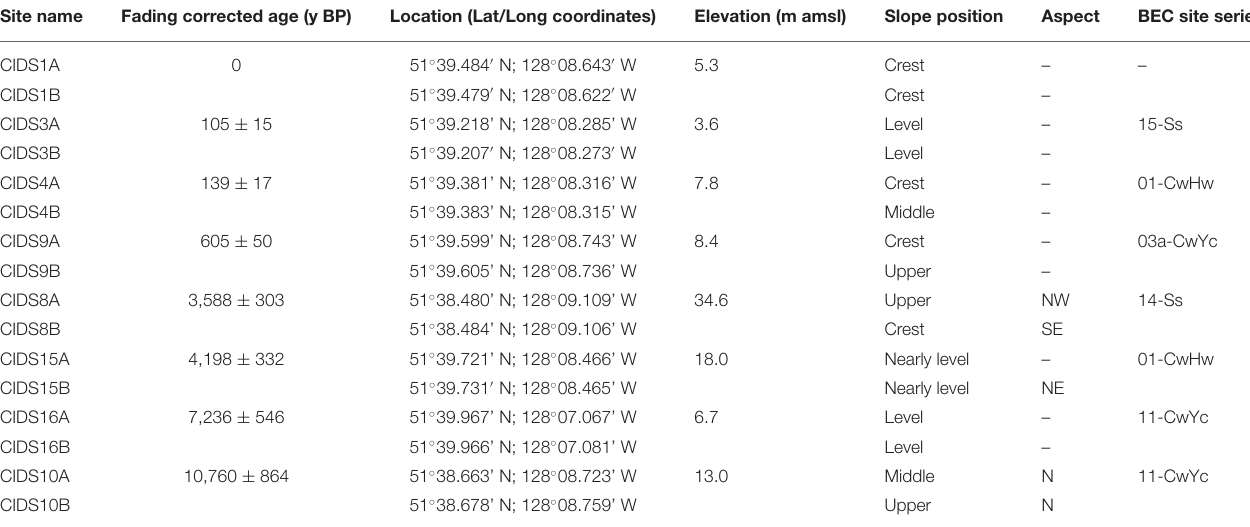
TABLE 2 | The sampling sites used in this study, including chronosequence site name, the most accurate age (in years before present, y BP), location, approximate elevation in meters above mean sea level (m amsl), slope position, aspect, and biogeoclimatic (BEC) site series classification (Green and Klinka,